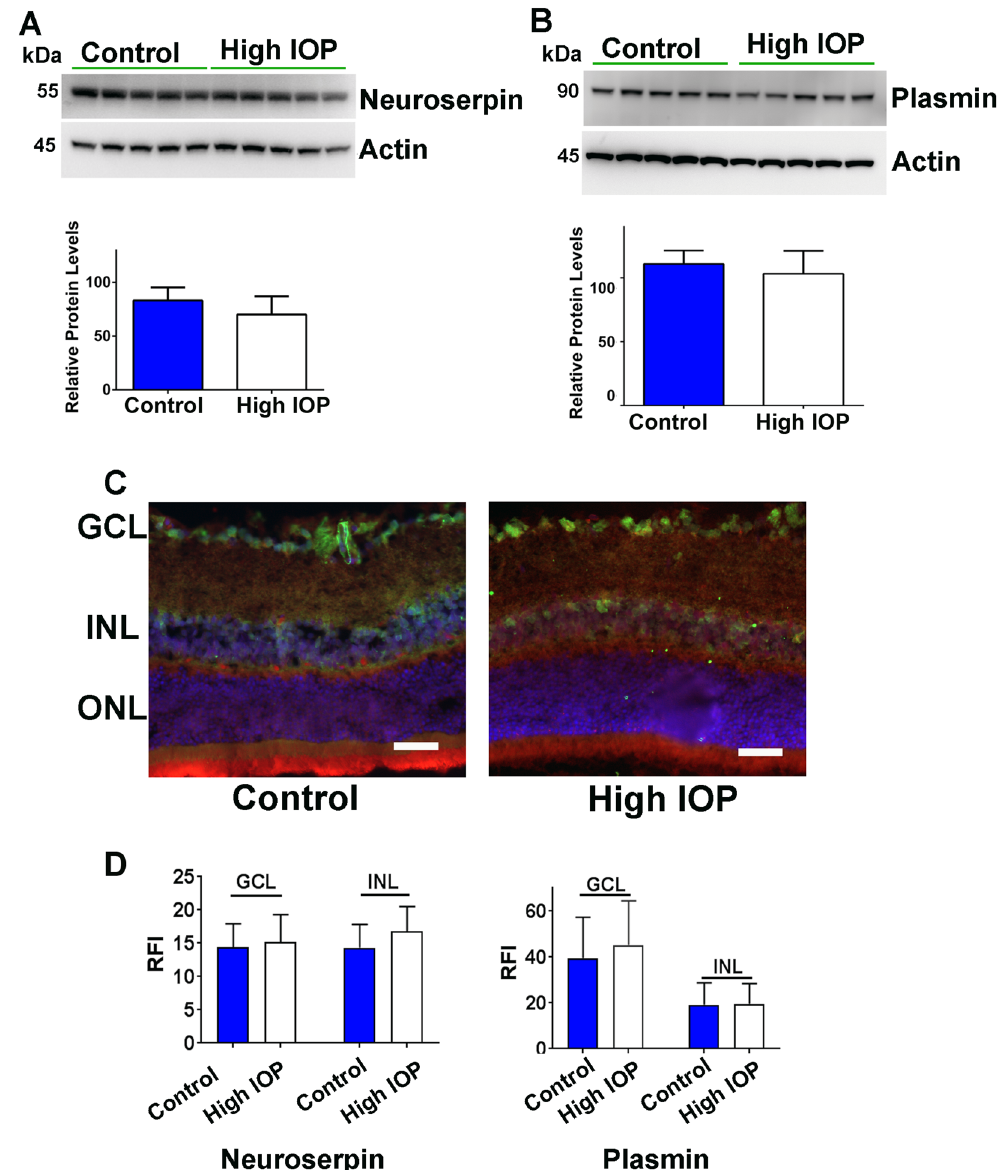
Figure 3. Rat retinal lysates from control and high IOP rats were subjected to western blotting and probed for ( A ) neuroserpin and ( B ) plasmin immunoreactivity. Actin was used as loading control. Blots were cropped to show the relevant band. The relative intensities of WB bands were quantified in both cases and plotted (n = 5 each). ( C ) Double immunostaining of the rat retinal sections from control and microbead induced high IOP eyes illustrating neuroserpin (red) and plasminogen (green) expression and localization in various retinal layers (Blue-DAPI). (n = 5; scale 50 µ m). ( D ) Relative fluorescence intensities of neuroserpin and plasmin immunoreactivity in sections were quantified using ImageJ programme in GCL and INL and